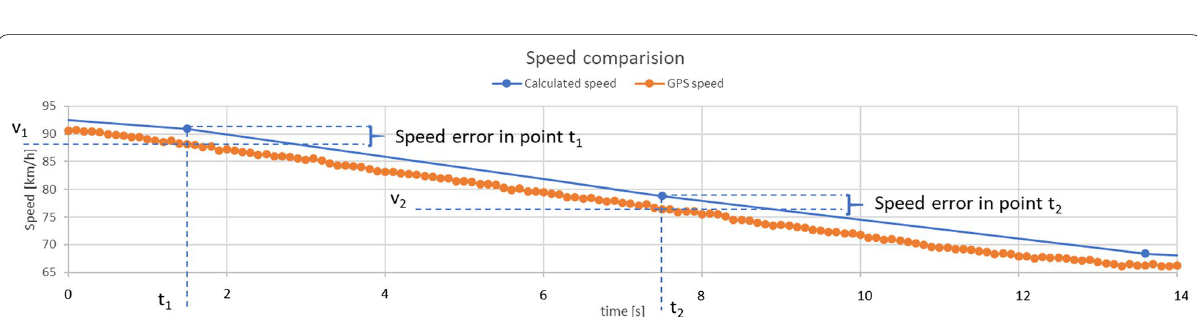
gps train speed at =